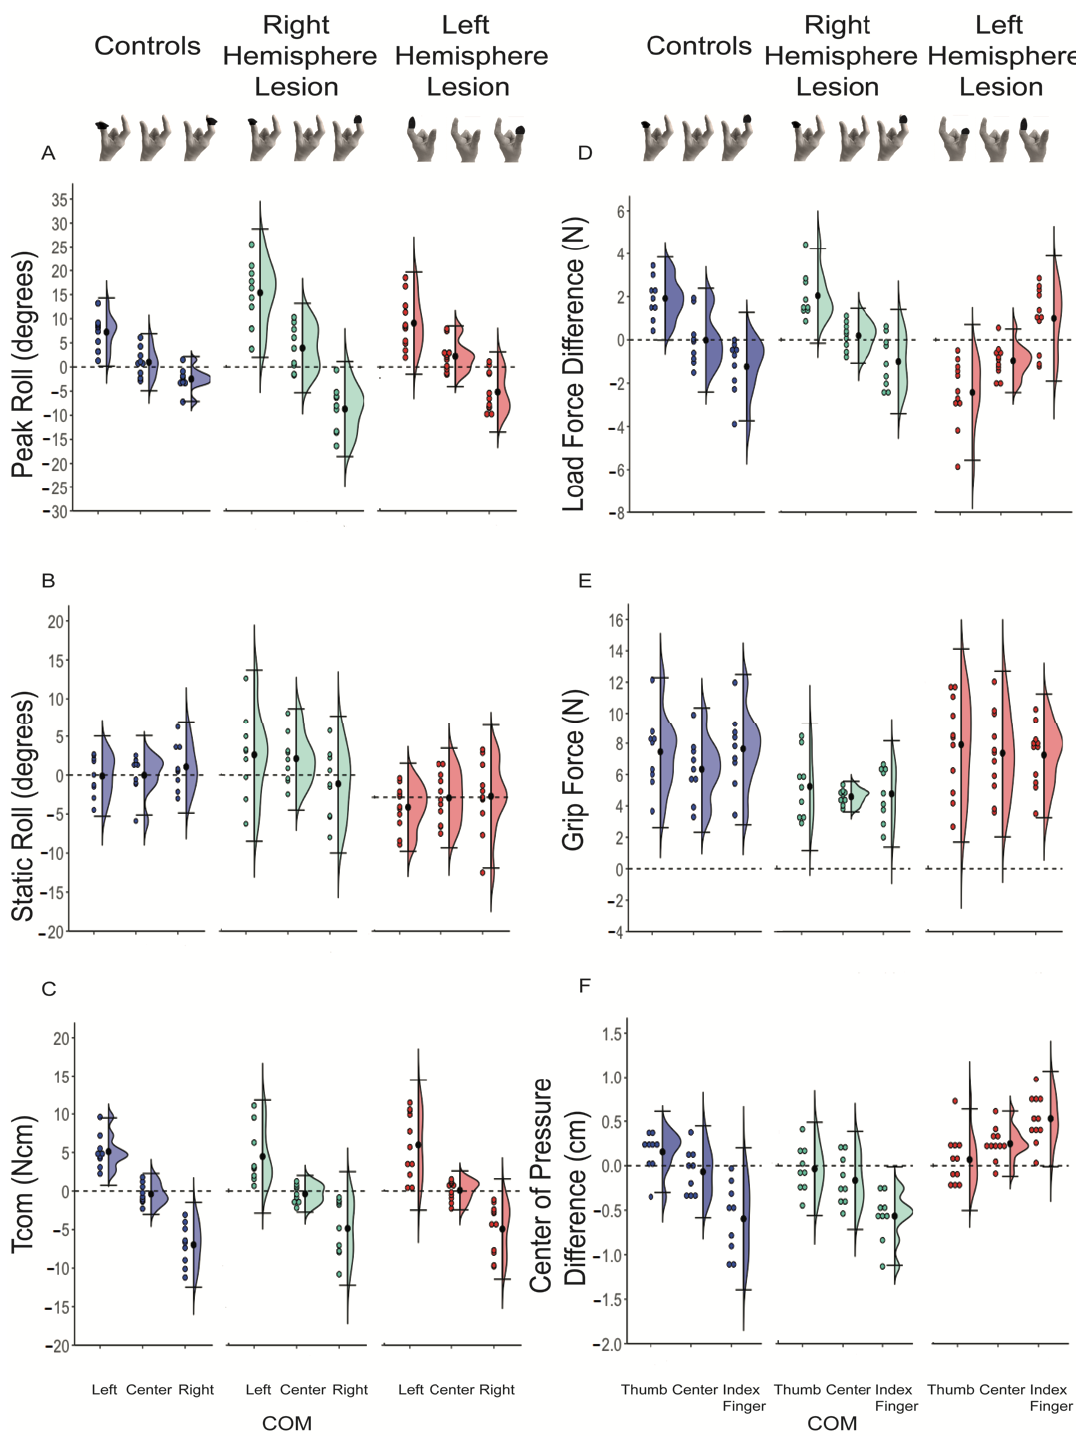
Figure 3. Violin plots ( A – F ). Group means for each group for the left center and right center of mass locations are denoted by the black dot, with ± standard error (SE) for peak roll, static roll and Tcom. Group means for each group for the thumb, center and index finger COM locations are denoted by a black dot, with ± SE for load force difference, grip force and center of pressure difference. Blue graphs represent the control participants, green represents the participants in the right hemisphere lesion group and red represents the participants in the left hemisphere lesion group. The black circle on the picture of the hand below the graph represents which digit was on the side the heavy COM was located. ( A ) Peak roll, ( B ) compensatory torque (Tcom), ( C ) load force difference (LF difference), ( D ) grip force (GF), ( E ) Center of Pressure Difference (COP difference), ( F ) static